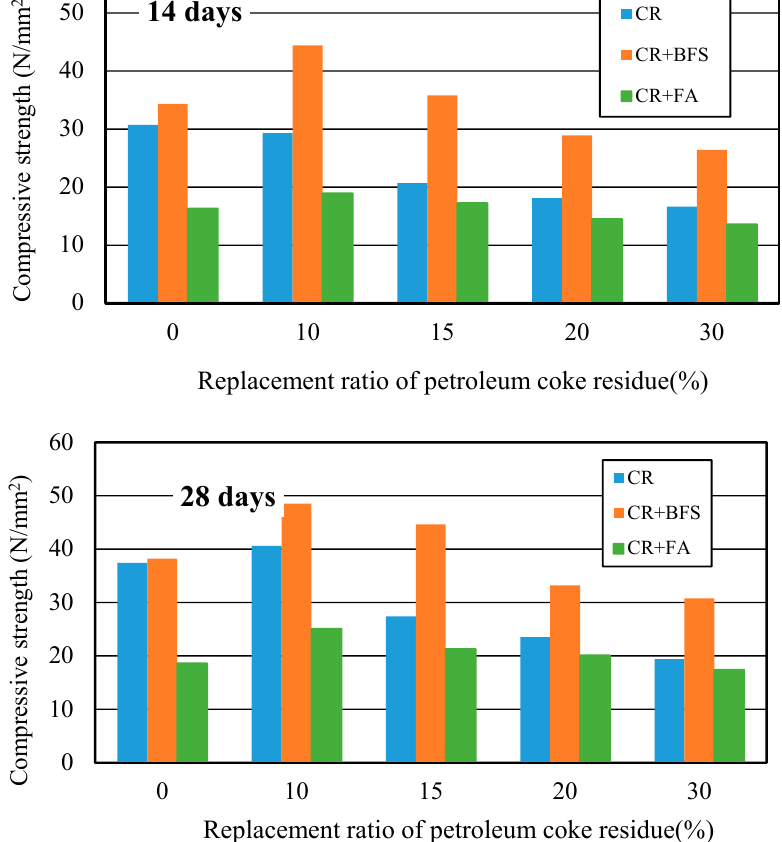
Figure 14. Compressive strengths of multi-added coke residue and mineral admixture concrete.